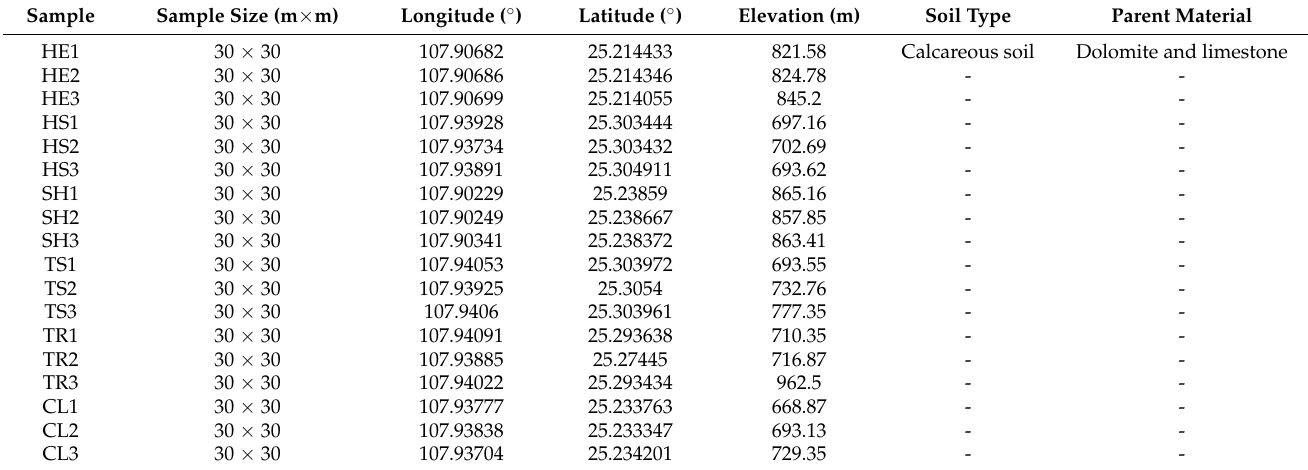
Figure 1. Overview map of the study area. CL—ultimate stage, TR—tree stage, TS—tree and shrub transition stage, SH—shrub stage, HS—grass and shrub transition stage, HE—herbaceous stage. Table 1. Sample site information overview. “-” represents the same as the previous column.